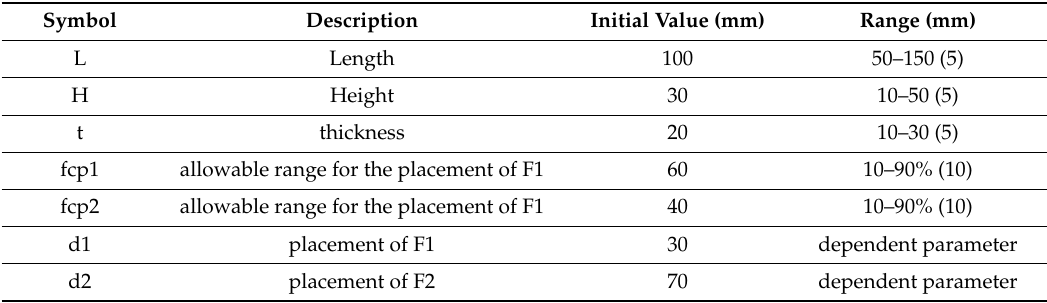
Table 6. The used design parameters (factors) in the optimization of the MBB-Beam, their description, initial value, allowable range, and value increment (step) in parentheses.